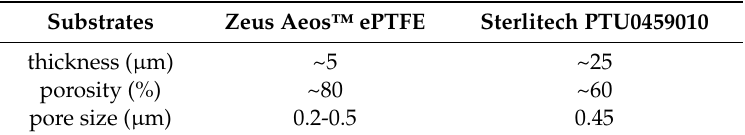
Table 2. Chemical structures of 3,4,5-trihydroxybenzoic acid (GA), 3-aminopropyltriethoxysilane Table 1. Specifications of poly(tetrafluoroethylene) (PTFE) substrates used in this study.